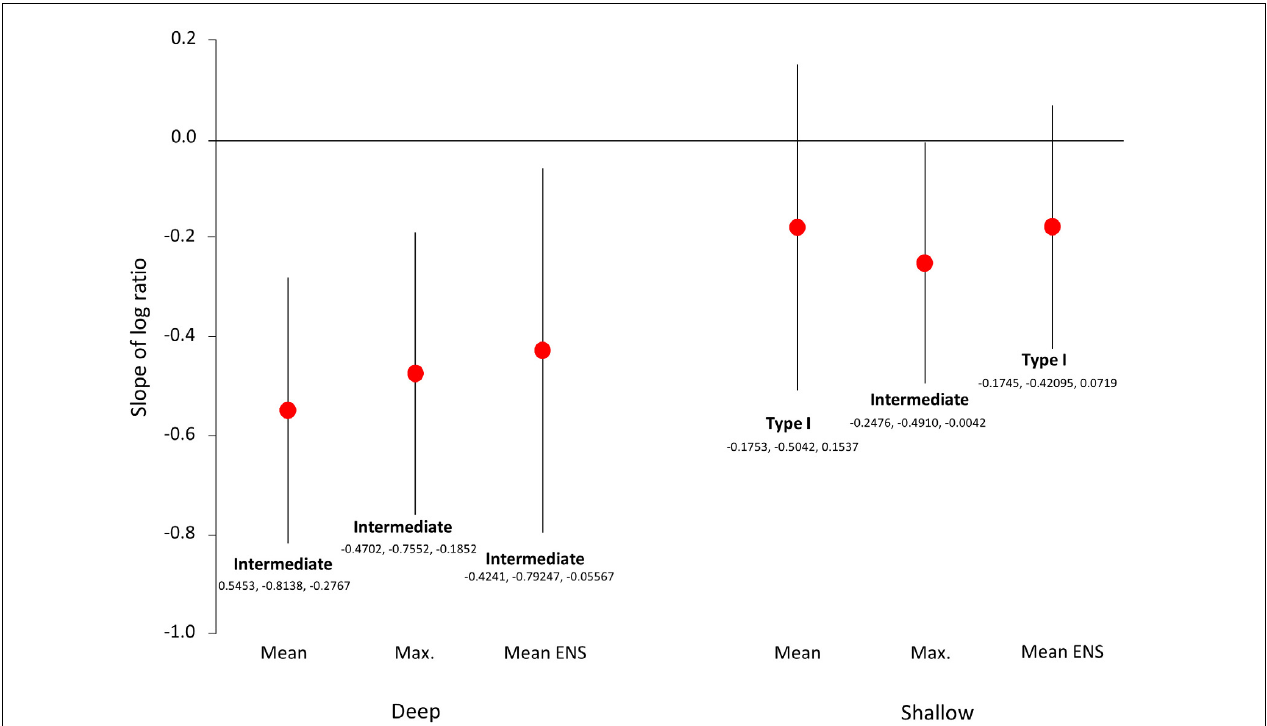
FIGURE 5 | Positions of log ratio regressions with respect to the Type I–Type II continuum for deep and shallow mean and maximum local richness and for ENS. Values of regression slopes (red dots) and 95% confidence intervals (error bars) are listed for each analysis.